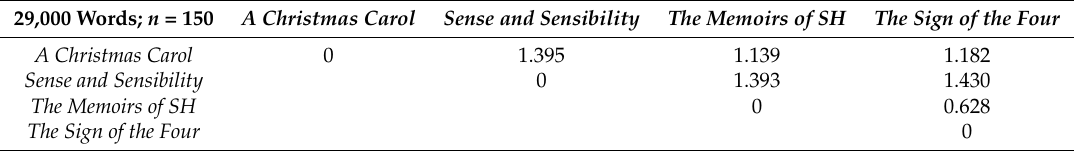
Table 4. Delta scores of first 29,000 words of each source novel ( n =